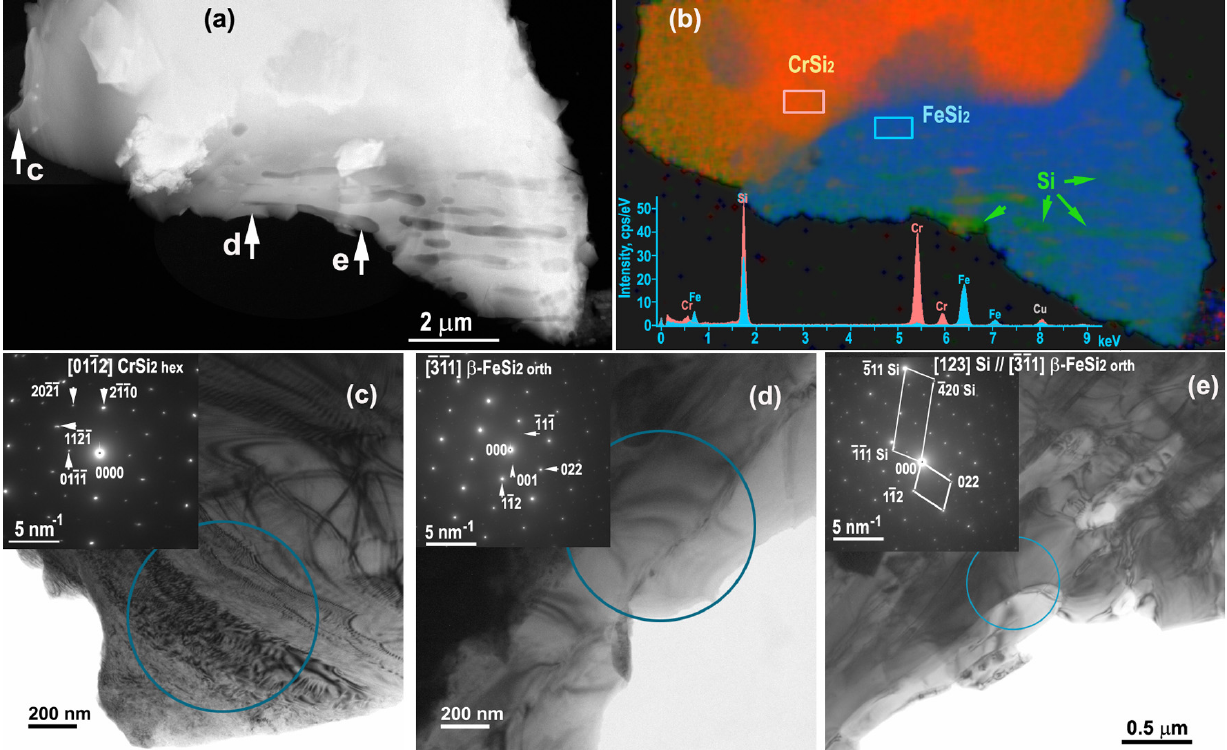
Figure 6. Annealed sample: HAADF STEM image ( a ) and EDXS map (in atomic %) showing grains CrSi 2 and FeSi 2 with Si precipitates ( b ); TEM images ( c − e ) with the corresponding SAED patterns taken from [0112] CrSi 2 hex, [331] β − FeSi 2 orth and [331] β − FeSi 2 orth with Si precipitates along the [123] direction.